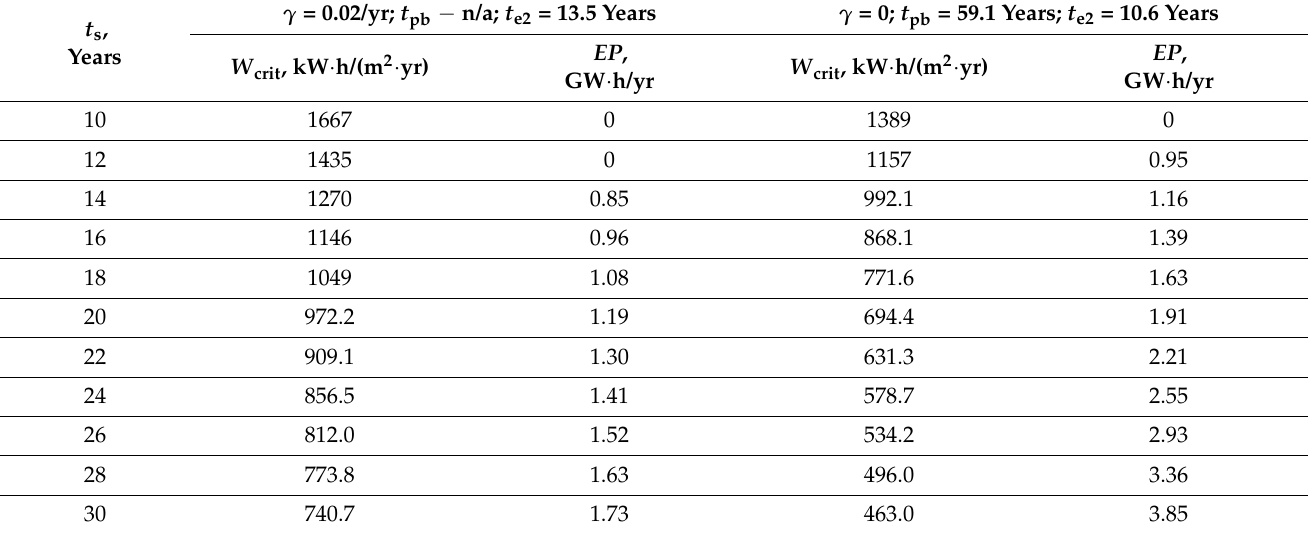
Table 11. Critical values of annual generation W crit by PV systems based on planar silicon PV modules with inclination of module active surfaces at the angle β opt , and relevant values of economic potential EP and economic surplus potential ∆ EP of solar energy for the photovoltaic energetics of the Island of Olkhon, subject to different service lifetimes of PV systems t s.